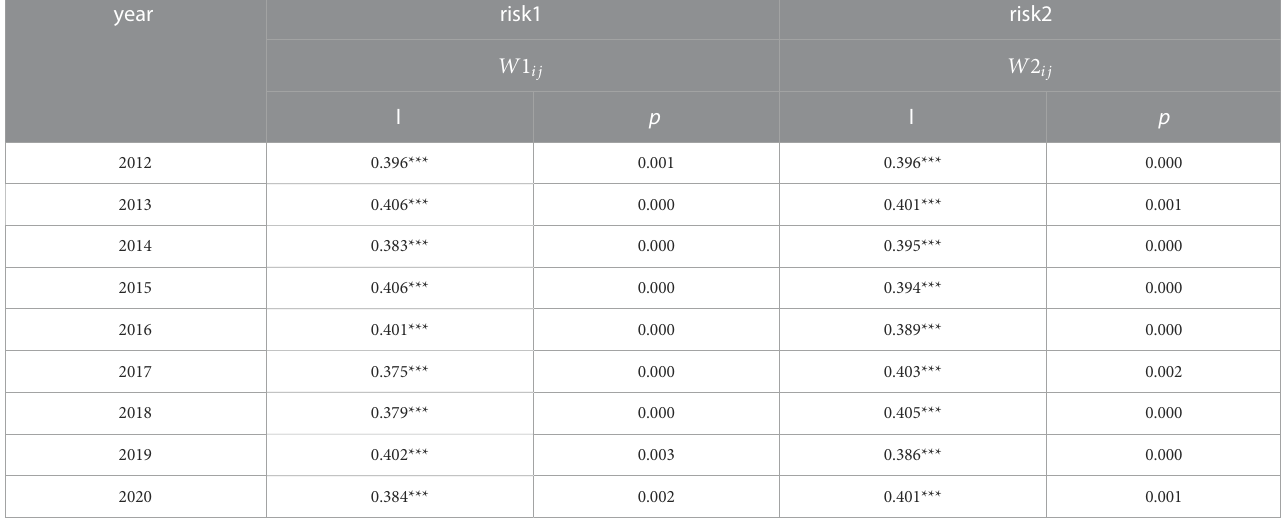
TABLE 3 Global Moran ’ s I index values of risk1 and